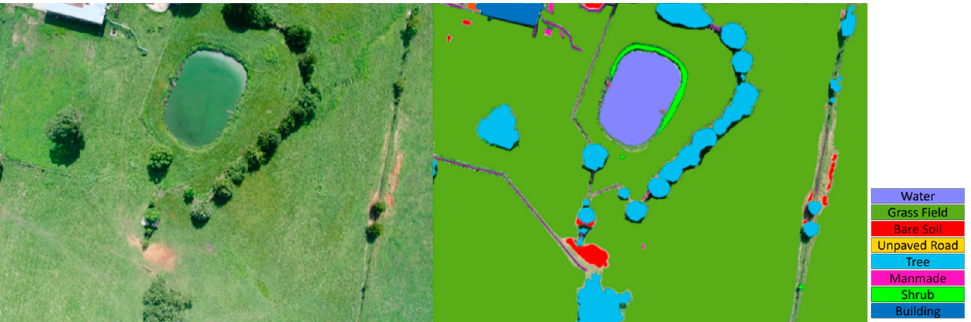
Figure 8. Example of semantic labeling of real-world data.